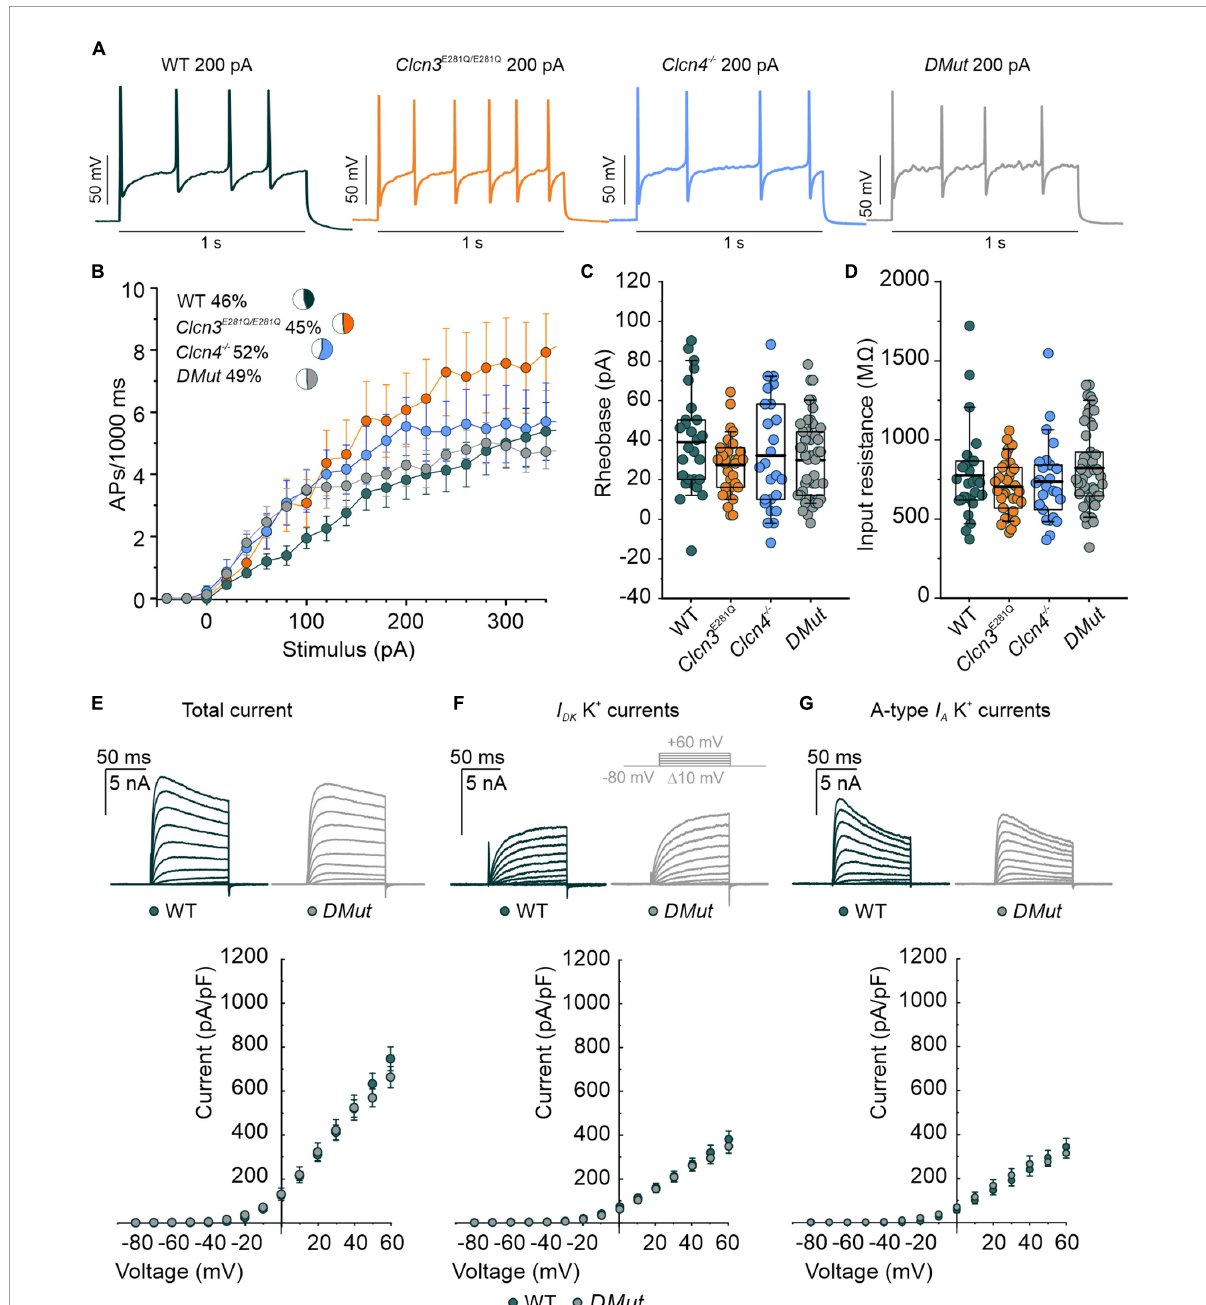
FIGURE4 Comparison of the action potential (AP) properties of wild type (WT), Clcn3 E 281 Q / E 281 Q , Clcn4 − / − , and Clcn3 E 281 Q / E 281 Q /Clcn4 − / − ( DMut ) dorsal root ganglion (DRG) neurons from adult mice. (A) Representative APs elicited by 200 pA current injection in adult WT (green), Clcn3 E 281 Q / E 281 Q (orange), Clcn4 − / − (blue), and DMut (gray) neurons. (B) AP frequencies for all conditions. Insets show the percentage of multiple firing neurons for each condition. (C) Rheobase and (D) input resistance. Data were collected from WT (green, n = 27 cells from three animals), Clcn3 E 281 Q / E 281 Q (orange, n = 31 cells from three animals), Clcn4 − / − (blue, n = 25 cells from three animals), or Clcn3 E 281 Q / E 281 Q /Clcn4 − / − - (gray, n = 49 from seven animals) neurons. (E–G) Representative recordings of the K + current (upper panel) and current–voltage relationship (lower panel) were obtained from WT (green, n = 16 from five animals) and DMut (gray, n = 10 from three animals) DRG neurons. The inset illustrates the voltage protocol used to elicit K + currents during and after 4-AP application. Total (E) , slow-inactivating (F), and fast-inactivating (G) K + currents densities are not different between phenotypes. One-way ANOVA or one-way Kruskal–Wallis ANOVA was used for statistical analysis. Data are presented as the mean ± SEM. In boxplots, boxes indicate the upper and lower quartiles, and whiskers the upper and lower 90